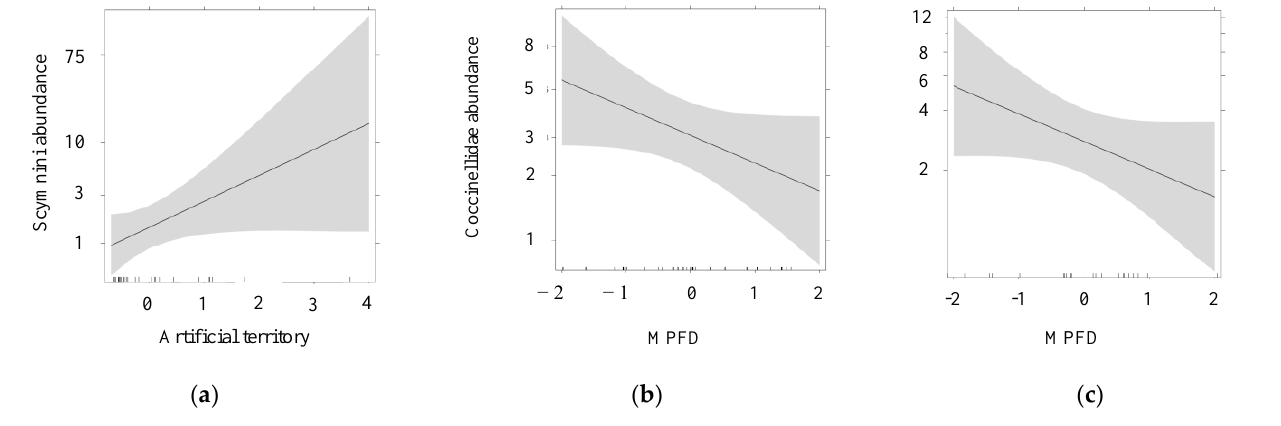
Figure 5. Response of the abundance of Scymnini to artificial territory and response of Coccinellidae to mean patch fractal dimension (MPFD) (standardized) surrounding vineyards at different buffers: ( a ) Scymnini — 750 m; ( b ) Coccinellidae — 2000 m; and ( c ) Coccinellidae — 1500 m.